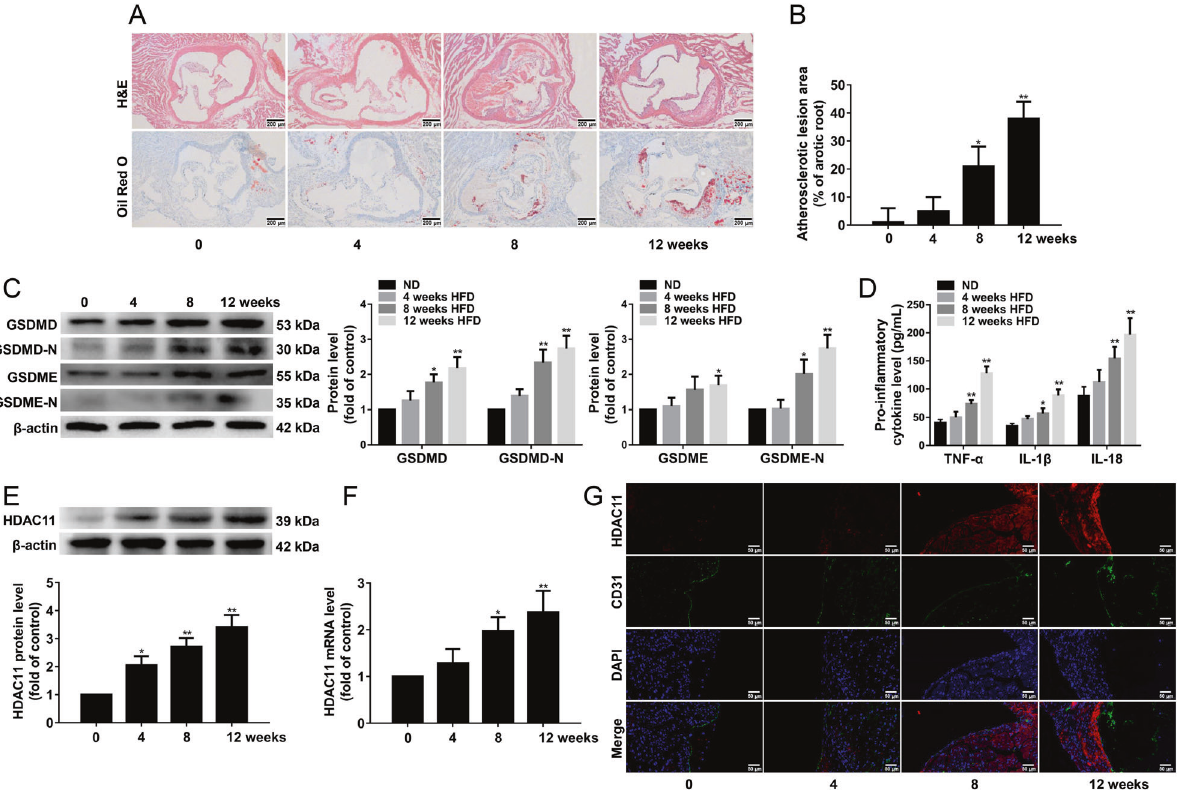
Fig. 1 HDAC11 expression is upregulated and pyroptosis is activated in the aorta of HFD-fed ApoE − / − mice. ApoE − / − mice were fed an HFD for 0, 4, 8, or 12 weeks. A Representative images showing the atherosclerotic lesions of aortic root sections with H&E staining and the lipid deposition of aortic root sections with Oil red O staining, ×100. Scale bar indicates 200 μ m. B The atherosclerotic lesion area of aortic root sections was analyzed ( n = 3). C GSDMD, GSDMD-N, GSDME, and GSDME-N protein expressions in the aorta were determined by Western blotting ( n = 3). D The levels of TNF- α , IL-1 β , and IL-18 in the serum were determined by ELISA ( n = 10). E , F HDAC11 protein and mRNA expressions in the aorta were determined by Western blotting and quantitative real-time PCR ( n = 3). G The expression of HDAC11 in aortic intima by immuno fl uorescent double staining of the aortic sinus of HDAC11 and CD31. The nuclei were stained blue with DAPI. Scale bar indicates 50 μ m. * P < 0.05, ** P < 0.01 vs. ND group. Results are expressed as mean ±